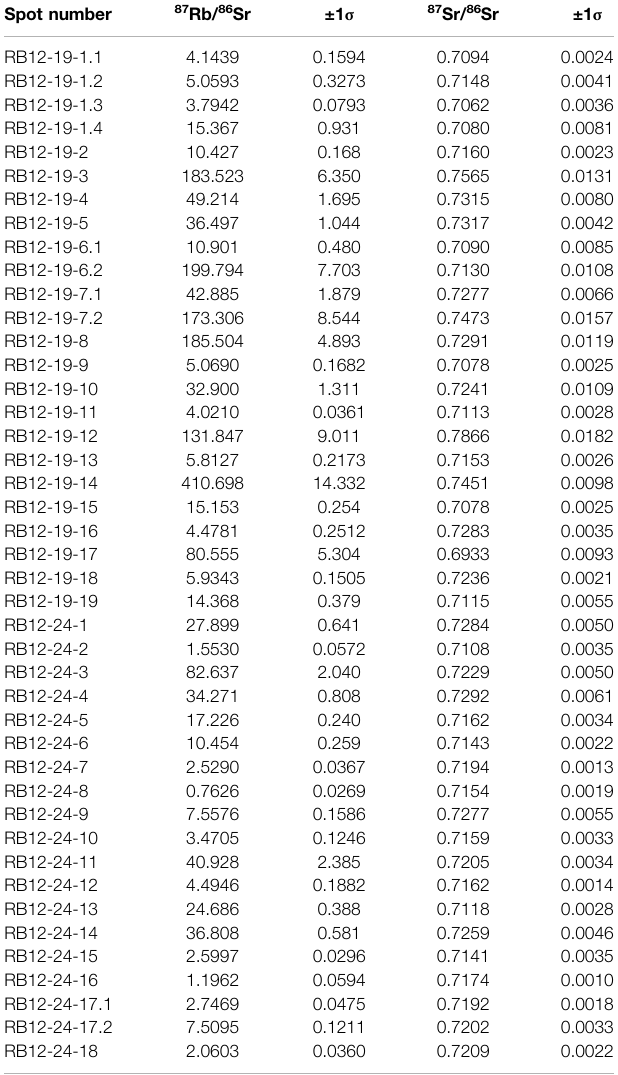
TABLE 2 | LA – ICP – MS biotite Rb – Sr data for the garnet – staurolite – two-mica schist samples RB12-19 and RB12-24 of the Ramba gneiss dome. Spot